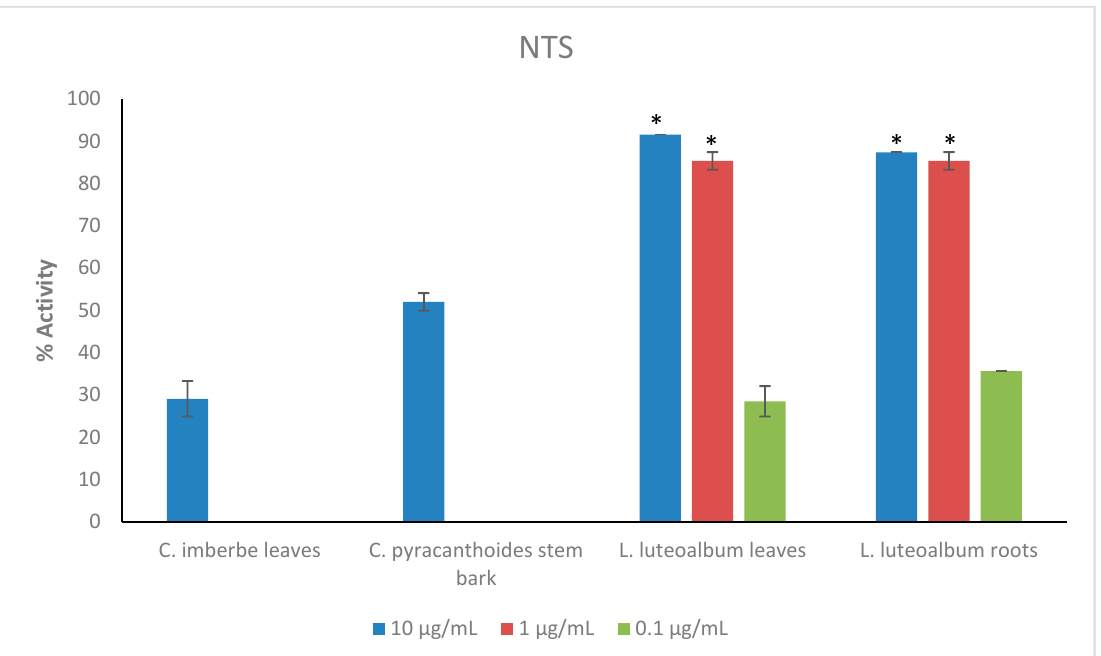
Figure 2 . Anthelmintic activity of the most active plant extracts at reduced concentrations against newly transformed schistosomula (NTS). Activity based on three replicates. Statistical analysis (one way ANOVA, p ≤ 0.001, and an all pairwise multiple comparison procedure (Tukey Test), * extract activities determined to be significant) was performed using SigmaPlot 14.0 (Supplementary Materials, Table S4).